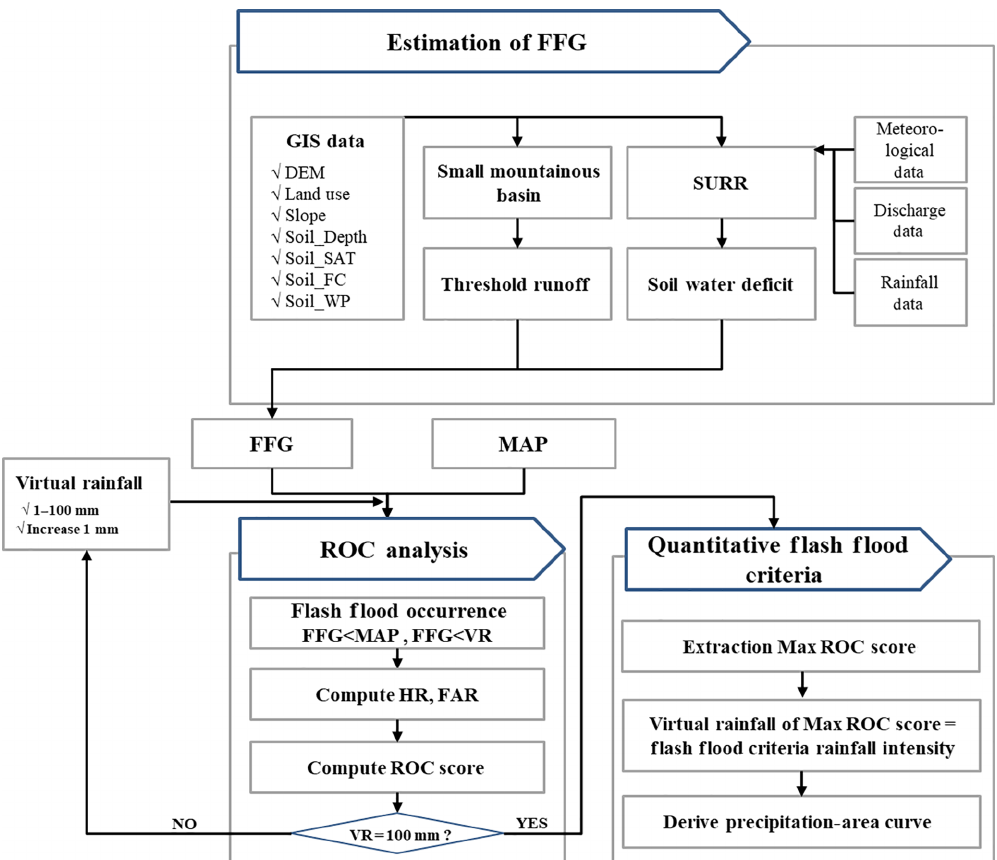
Figure 4. Overall methodology used to estimate the quantitative precipitation